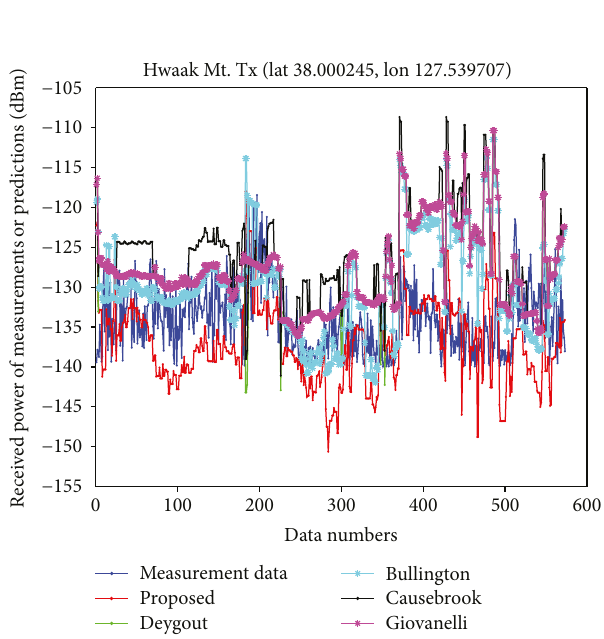
Figure 17: Comparison in the area where data are not used in training (Mt.